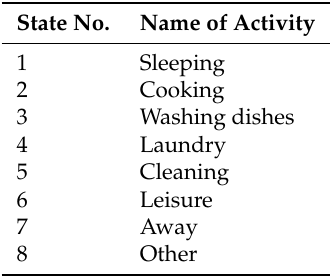
Table 2. The states corresponding to the activities. State